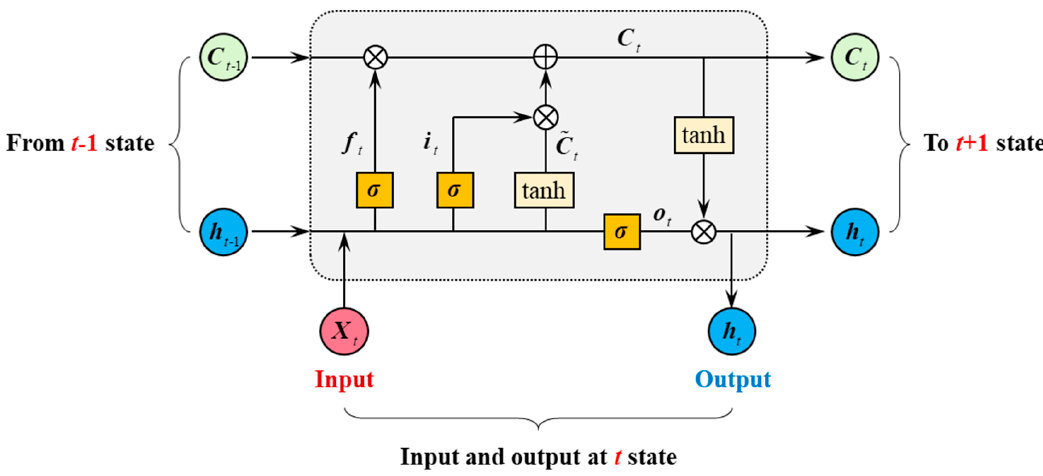
Figure 2. The internals of a Simple Recurrent Neural Network (RNN) memory cell.